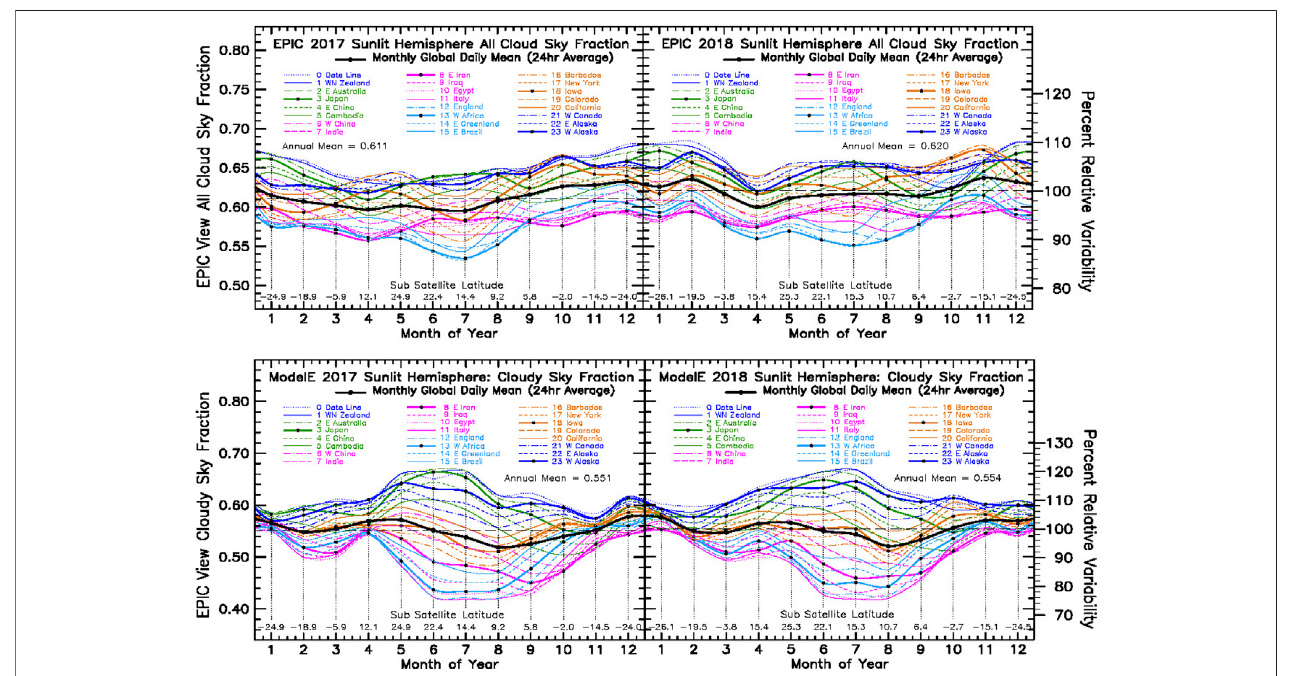
FIGURE5| All-cloudcloudy sky fraction (Top Panel) from EPIC Composite analysisresults forthe year 2017 (Top Left) and 2018 (TopRight) . (Bottom Panel) : All-cloud cloudy sky fraction from GISS ModelE2 SHS in-line sampling results for the year 2017 (Bottom Left) and 2018 (Bottom Right) .